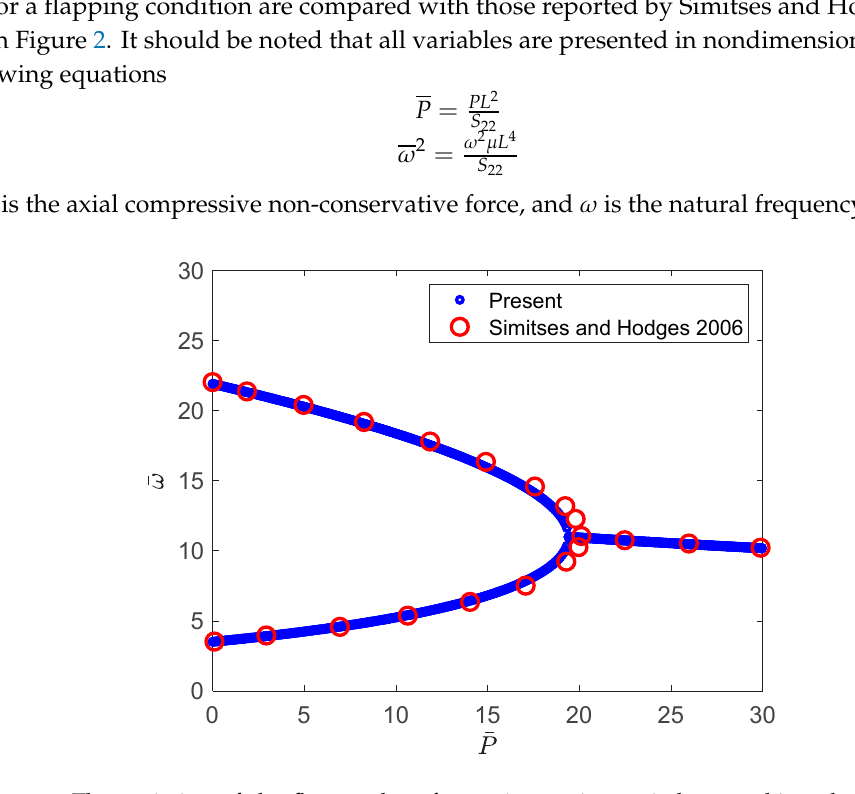
Figure 2. The variation of the flap modes of a stationary isotropic beam subjected to an axial non-conservative force.